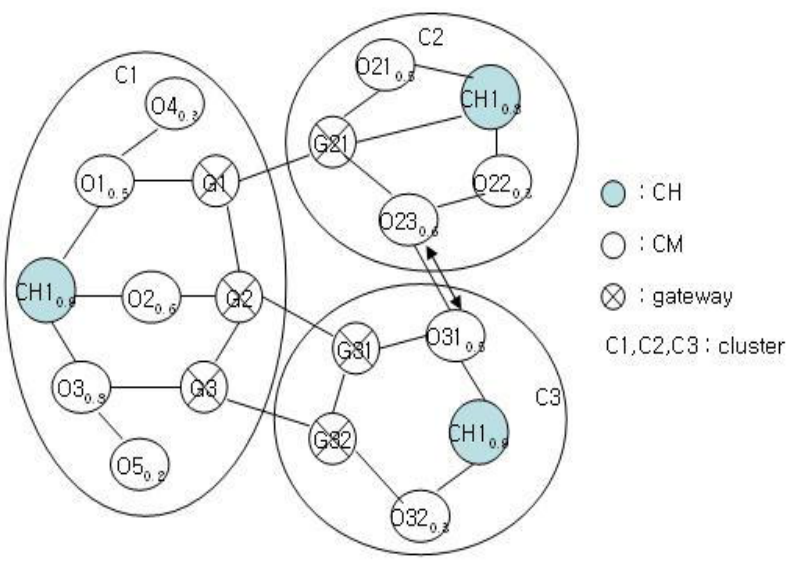
Figure 4. Original Cluster Structure.